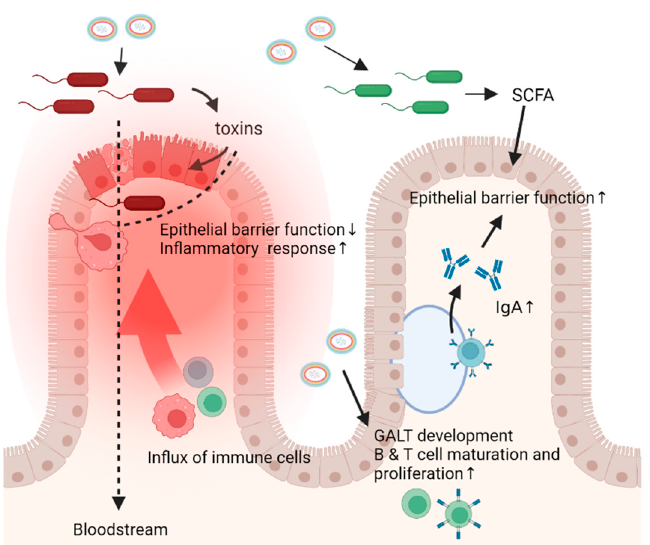
Figure 1. Interactions between spore forming bacteria and the intestine . Spore forming bacteria can act in the intestine both as spore and vegetative cells after germinating under the influence of germinants such as bile acids, amino acids, and other compounds. On the left, interactions with pathogenic spore forming bacteria are illustrated. Once sporulated, these bacteria produce toxins that act locally by interacting with the epithelium and altering immune responses, leading to cell death, tissue damage, and subsequently reduced epithelial barrier function causing a leaky gut. When this happens, inflammatory responses are evoked, and certain bacteria and toxins can travel from the gut to the bloodstream leading to damage in other places in the body such as motor nerve endings which ultimately leads to paralysis. On the right, interactions with beneficial spore forming bacteria are illustrated. Spores can induce GALT development and maturation and proliferation of T and B cells. Mature B cells produce IgA which benefits the epithelial barrier function and promotes bacte- rial tolerance. This epithelial barrier function is also improved by the action of SCFA, produced by vegetative commensals which are often spore formers. In addition, SCFA are linked to improved gut homeostasis and suppressed inflammatory responses. 4. Potential of Sporobiota as Treatment Various human disorders are associated with dysbiosis and depletion of beneficial species, therefore, modification of the gut microbiota seems to be an attractive solution. Spores represent an appealing vehicle for therapeutic use, due in part to their highly re- sistant makeup, ensuring stable shelf lives and increasing the likelihood of survival within the gastro-intestinal tract [164]. Below, we will discuss some of the modern uses of bacte- rial spores as well as currently developing strategies. 4.1. Spores as Probiotics Probiotics have been studied extensively for many years and have proven helpful in the management of disorders involving inflammation such as inflammatory bowel dis- ease and metabolic syndrome [173]. Spore-forming bacteria constitute perfect candidates for probiotic use, as they can be safely processed and purified in a laboratory setting, en- suring delivery of specified species, including strict anaerobes. Finally, the use of spores as probiotics is far less invasive than other microbiota restoring treatment options, such as fecal microbiota transplantation.